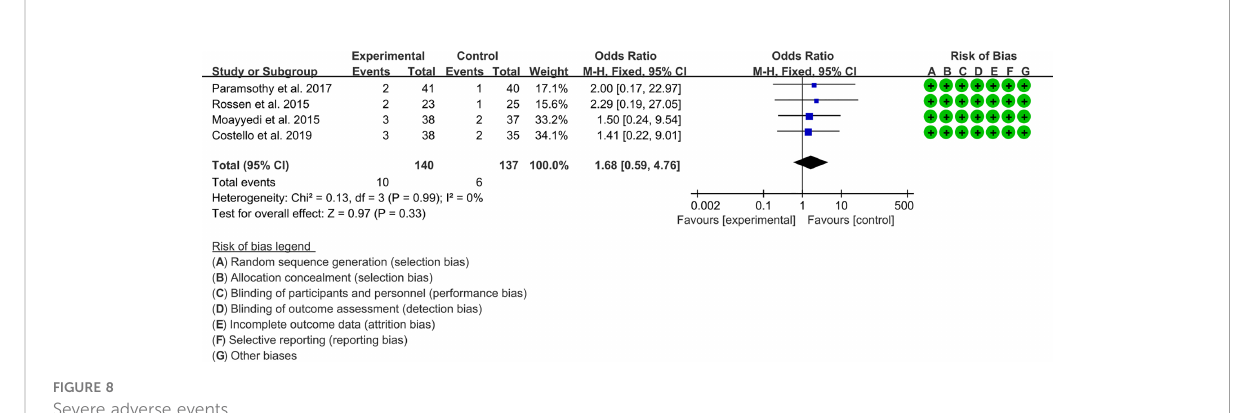
FIGURE 8 Severe adverse